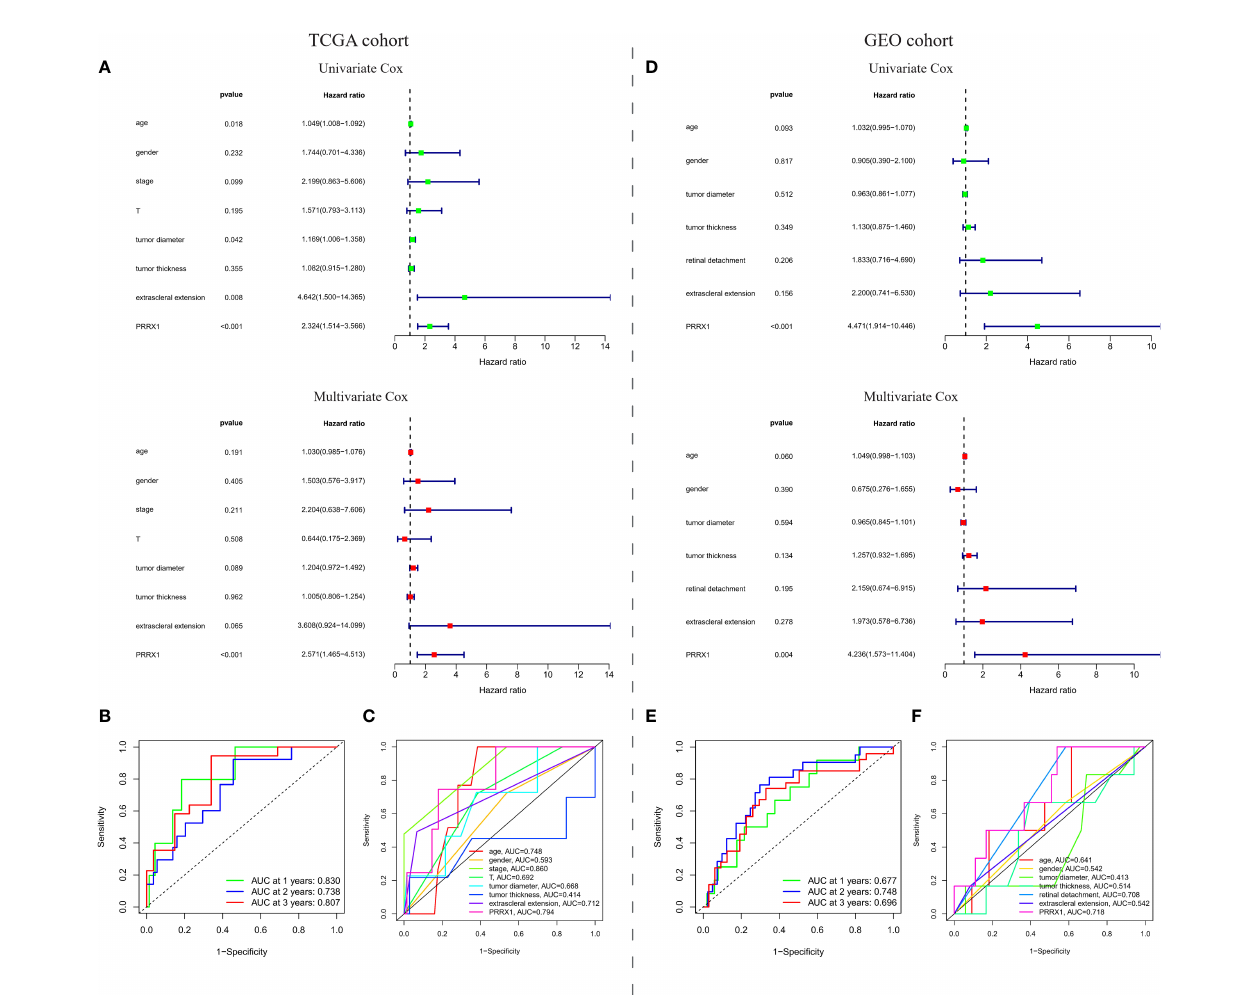
FIGURE 6 | Prognostic predictive ability of PRRX1 expression. (A) Univariate and multivariate Cox analyses of PRRX1 expression and seven other clinicopathological parameters in the TCGA cohort. (B) Time-dependent ROC analysis for prediction of OS in the TCGA cohort. (C) ROC analyses of PRRX1 expression and other seven clinicopathological parameters for predicting OS in the TCGA cohort. (D) Univariate and multivariate Cox analyses of PRRX1 expression and six other clinicopathological parameters in the GEO cohort. (E) Time-dependent ROC analysis for prediction of MFS in the GEO cohort. (F) ROC analyses of PRRX1 expression and other six clinicopathological parameters for predicting MFS in the GEO cohort. Corresponding AUC of each curve is displayed in the lower right corner of each fi gure, the higher the AUC value, the better the predictive power of the